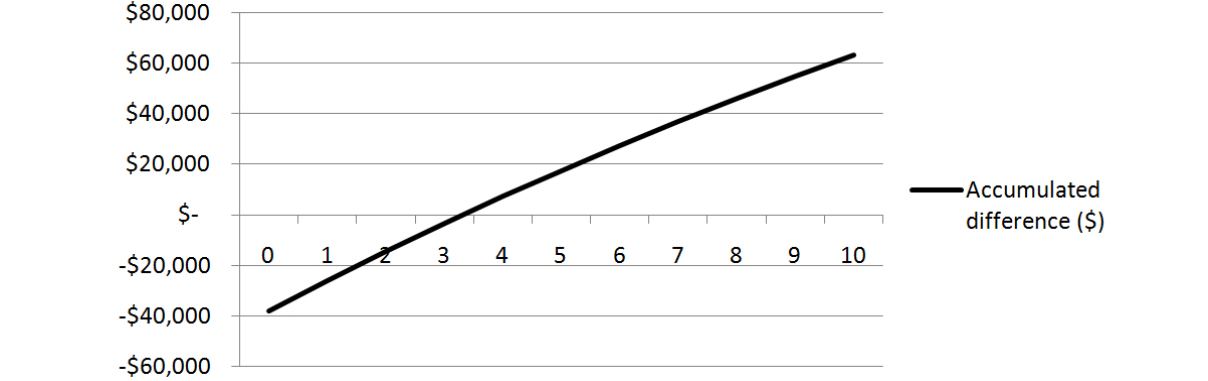
Figure 4. The accumulated difference in the PV of cost between F2F and BL across 10